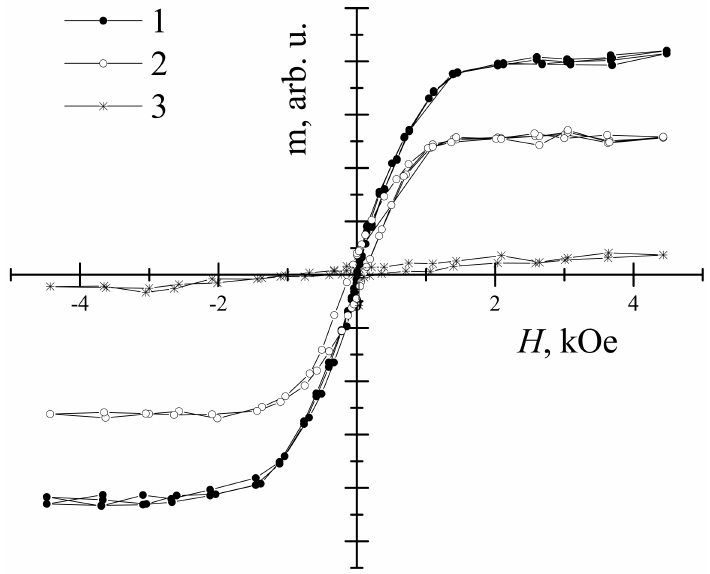
Figure 7. Magnetization hysteresis of: 1—YIG, 2—YIP, and 3—TIP thin layers. Magnetic field is perpendicular to the layer surface.